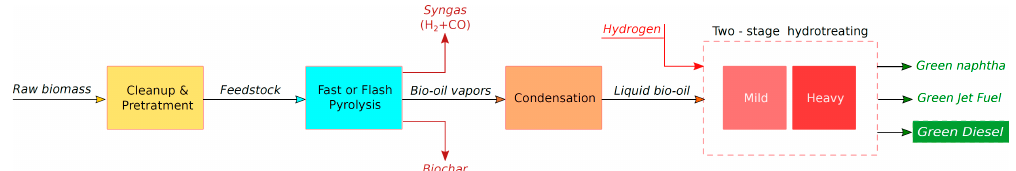
Figure 5. Typical flow chart for the production of green diesel from the pyrolysis of biomass and the hydrotreatment of bio-oil. hydrotreatment of